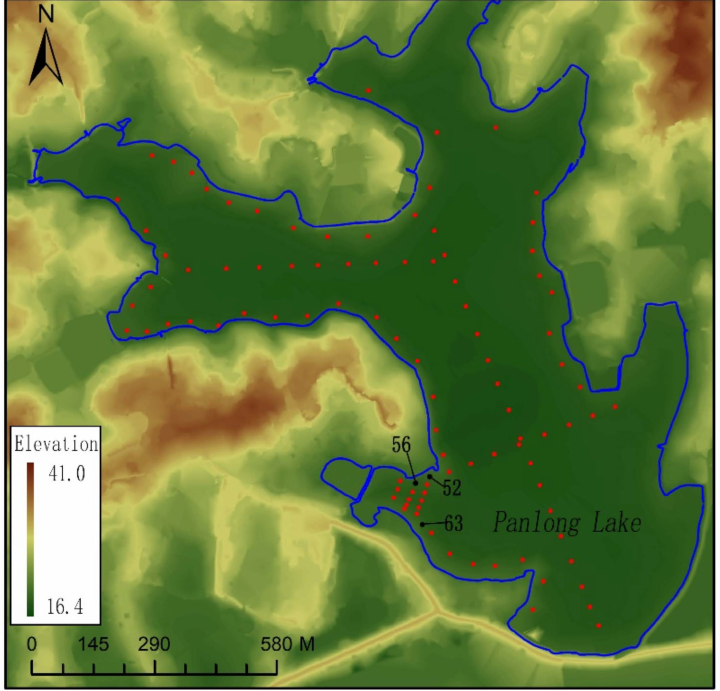
Figure 7. The distribution of the underwater drilling holes, in which some pottery sherds were found in No. 52, 56 and 63 drilling